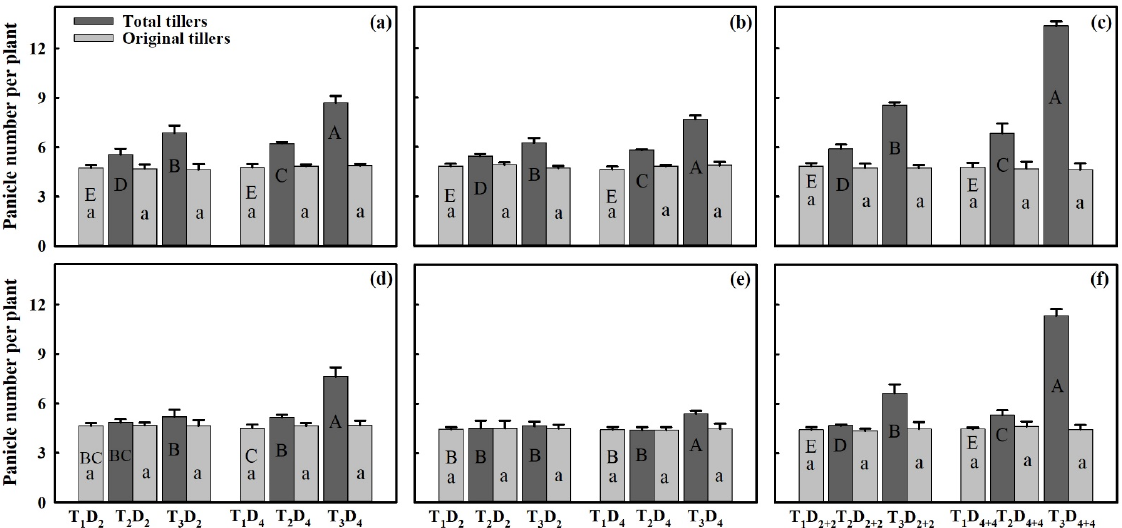
Figure 3. Effects of different high ‐ temperature levels treatments on panicle number per plant including total (original and regenerated tillers) and original tillers of Huaidao ‐ 5 and Wuyunjing ‐ 24 at booting (BT), flowering (FL), and combined (BT + FL) stages. ( a ) Huaidao ‐ 5 at BT treatment; ( b ) Huaidao ‐ 5 at FL treatment; ( c ) Huaidao ‐ 5 at BT + FL treatment; ( d ) Wuyunjing ‐ 24 at BT treatment; ( e ) Wuyunjing ‐ 24 at FL treatment; ( f ) Wuyunjing ‐ 24 at BT + FL treatment. Different uppercase and lowercase letters indicate significant differences at 0.05 level for total and original tillers, respectively. Vertical bars represent the standard deviation of the mean.